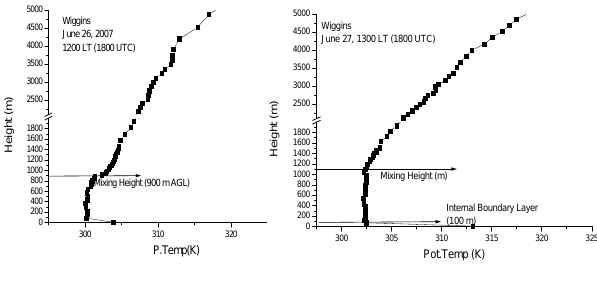
Figure 6 : Vertical profiles of potential temperature at Wiggins site on June 26 and June 27 at 13:00 LT. During the sea breeze time at Seabee base (Navy base), the profiles at 13:00 LT for potential temperature, relative humidity, wind speed and wind direction are examined. The profiles for temperature and RH clearly show a shallow unstable layer near the ground (Fig. 7). Temperature distribution is gradually altered and a shallow unstable layer marked with steep lapse rate is seen up to 150 m AGL and a mixed layer up to 500 m AGL at 13:00